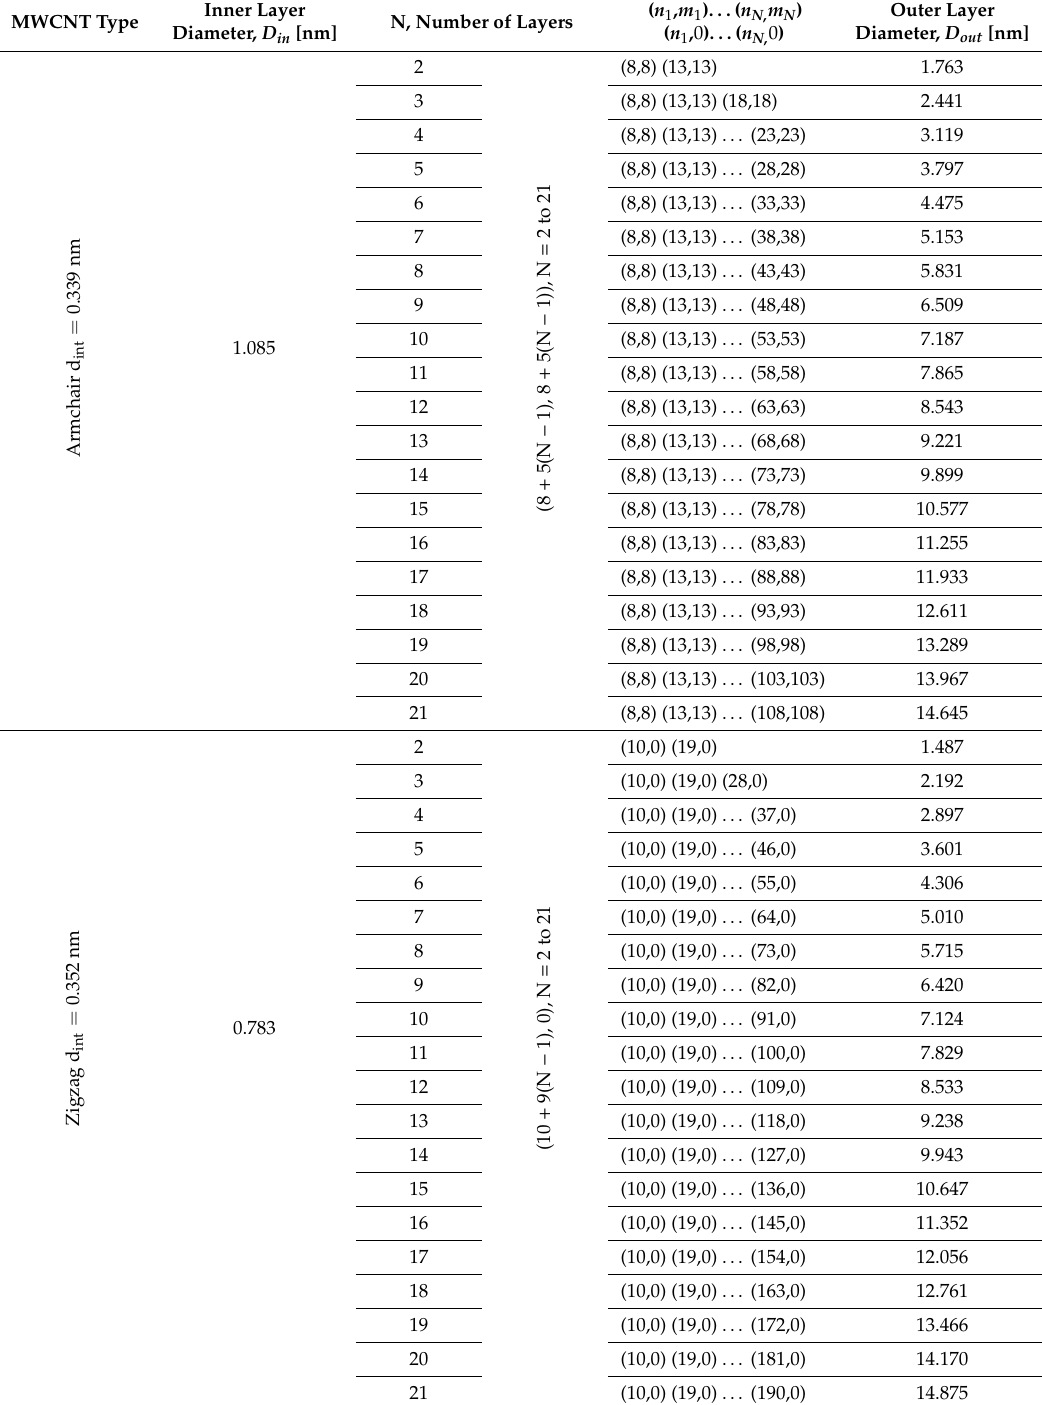
Table 5. Geometrical characteristics of armchair and zigzag MWCNTs for testing the methodology proposed. MWCNT